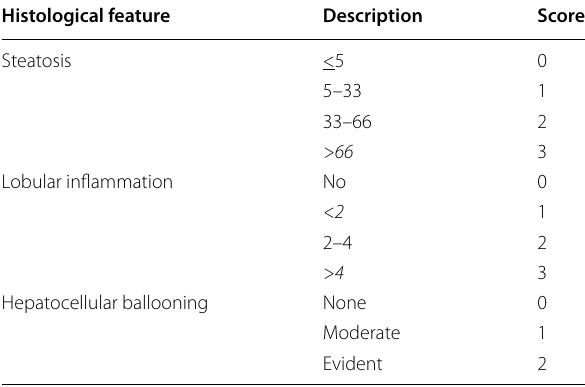
Table 1 NAS score (NAFLD activity score) Histological feature